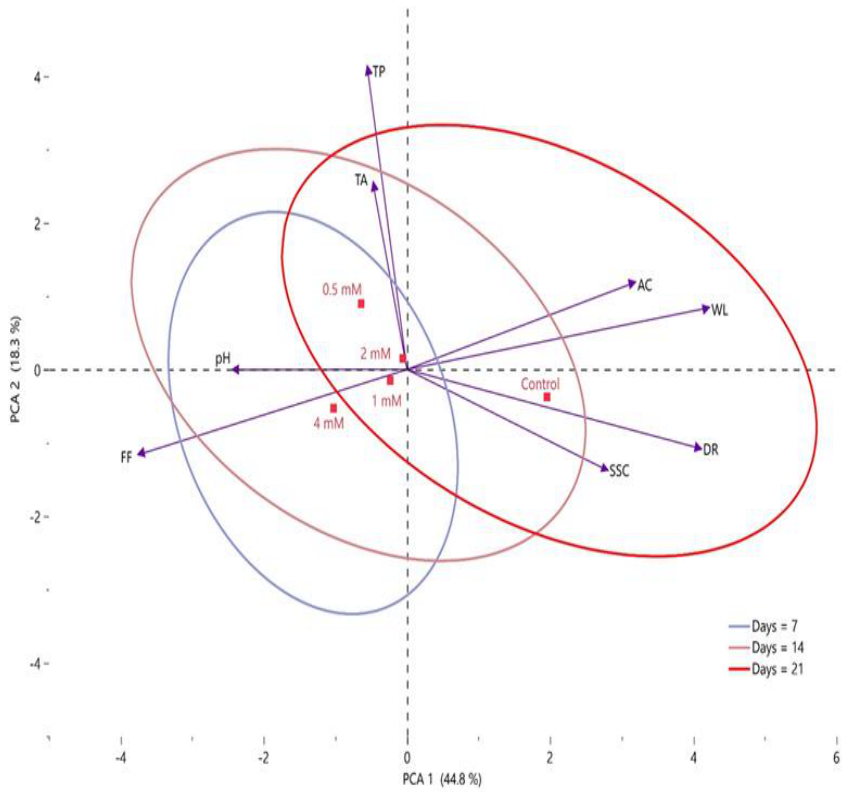
Figure 8. Determination of the effects of putrescine doses (control, 0.5 mM, 1 mM, 2 mM, and 4 mM) on agromorphological properties during storage by PCA. WL: Weight loss, SSC: Soluble